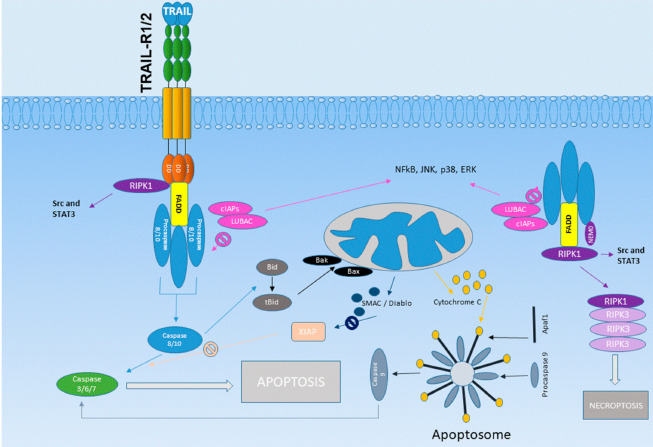
Figure 2. TRAIL-R1 / R2 signaling. TRAIL-R1 / TRAIL-R2 trimerization upon TRAIL-binding can lead